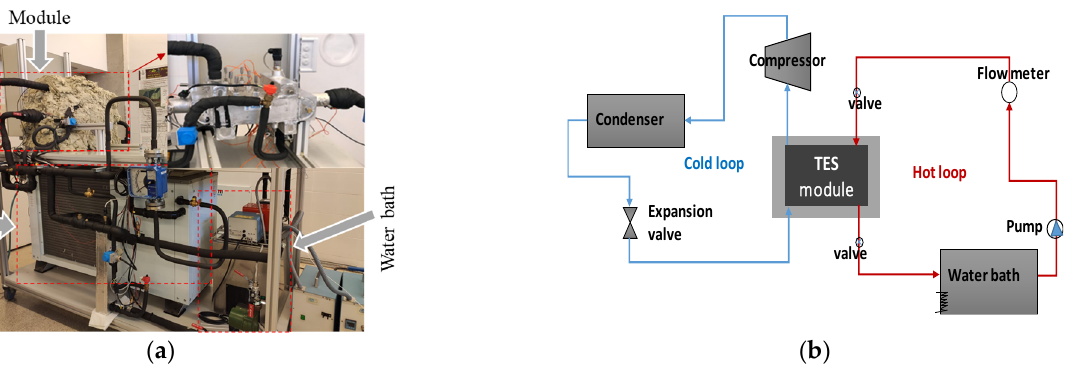
Figure 2. Experimental facility: ( a ) photo of the test-rig and ( b ) schematic diagram.